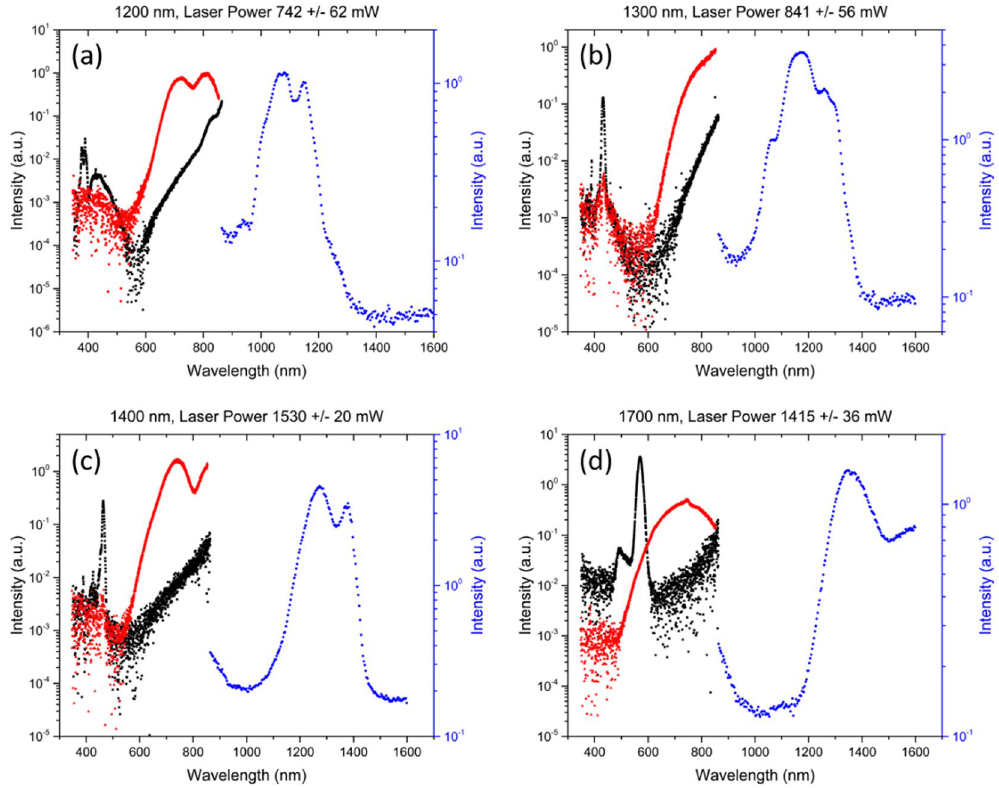
Figure 3. Supercontinuum spectra of the center (black) and fringes (red) of the visible output as well as the center output of the IR (blue) are shown above. The left axis corresponds to the visible light data, and the right axis corresponds to infrared data. Source wavelengths shown are ( a ) 1200 nm ( b ) 1300 nm ( c ) 1400 nm ( d ) 1700 nm. Intensities shown were corrected using the relative efficiencies from the LS-1 light